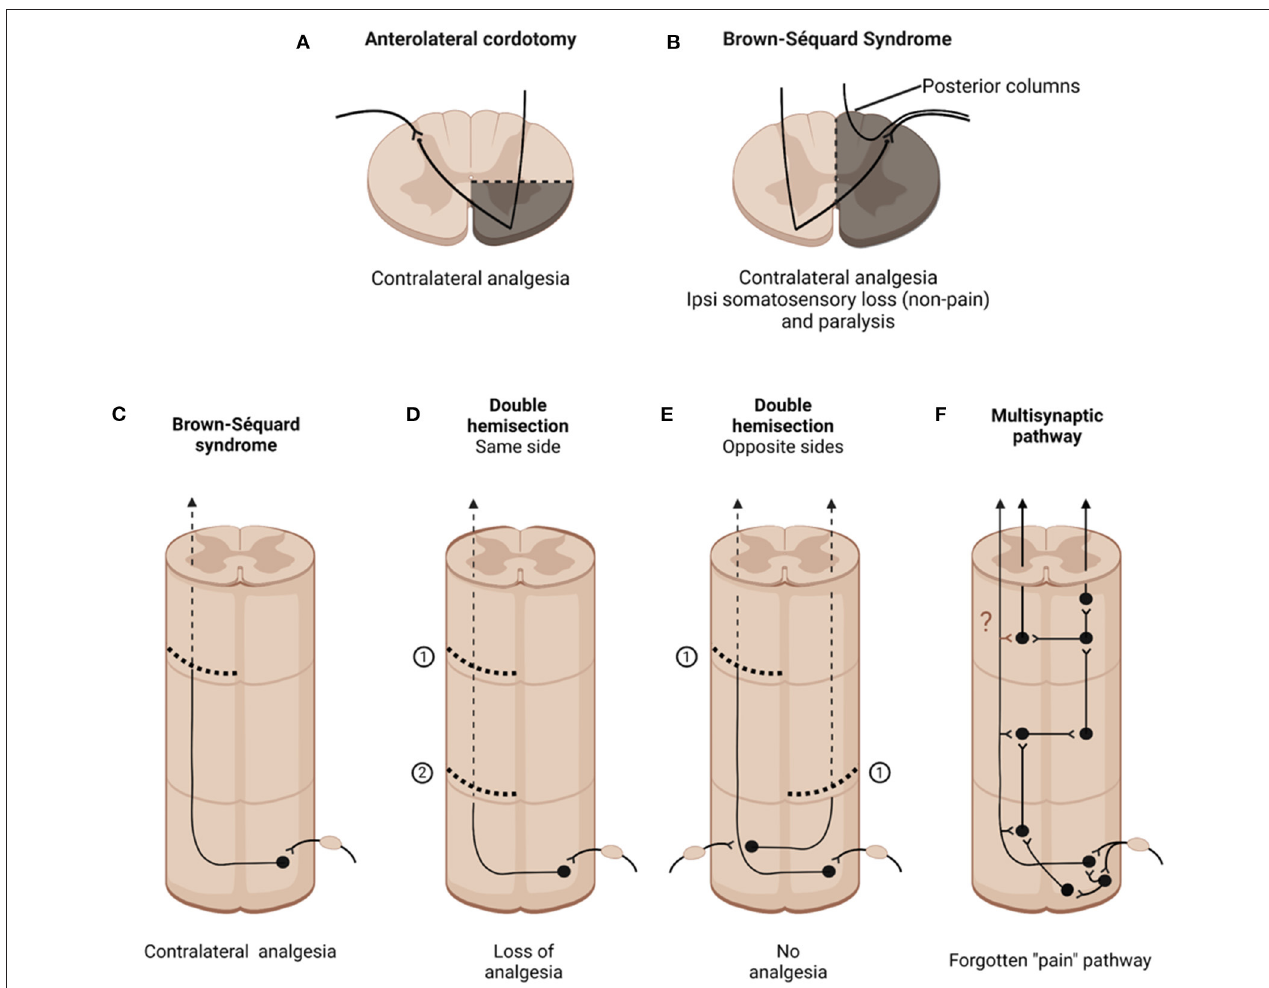
FIGURE 1 | Consequences of cutting different spinal cord pathways. (A) Anterolateral cordotomy purportedly provokes contralateral analgesia below the lesion, albeit not permanently. (B) Brown-Sequard Syndrome produced by hemisection of the spinal cord. (C–F) Longitudinal views of different spinal cord pthways and lesions. (C) Unilateral hemisection; (D) Double hemisection performed on the same side of the spinal cord; (E) Spaced hemisection performed on opposite sides of the spinal cord; (F) Illustrates how a multisynaptic system that interconnects the two sides of the spinal cord can “escape” lesions to the long ascending